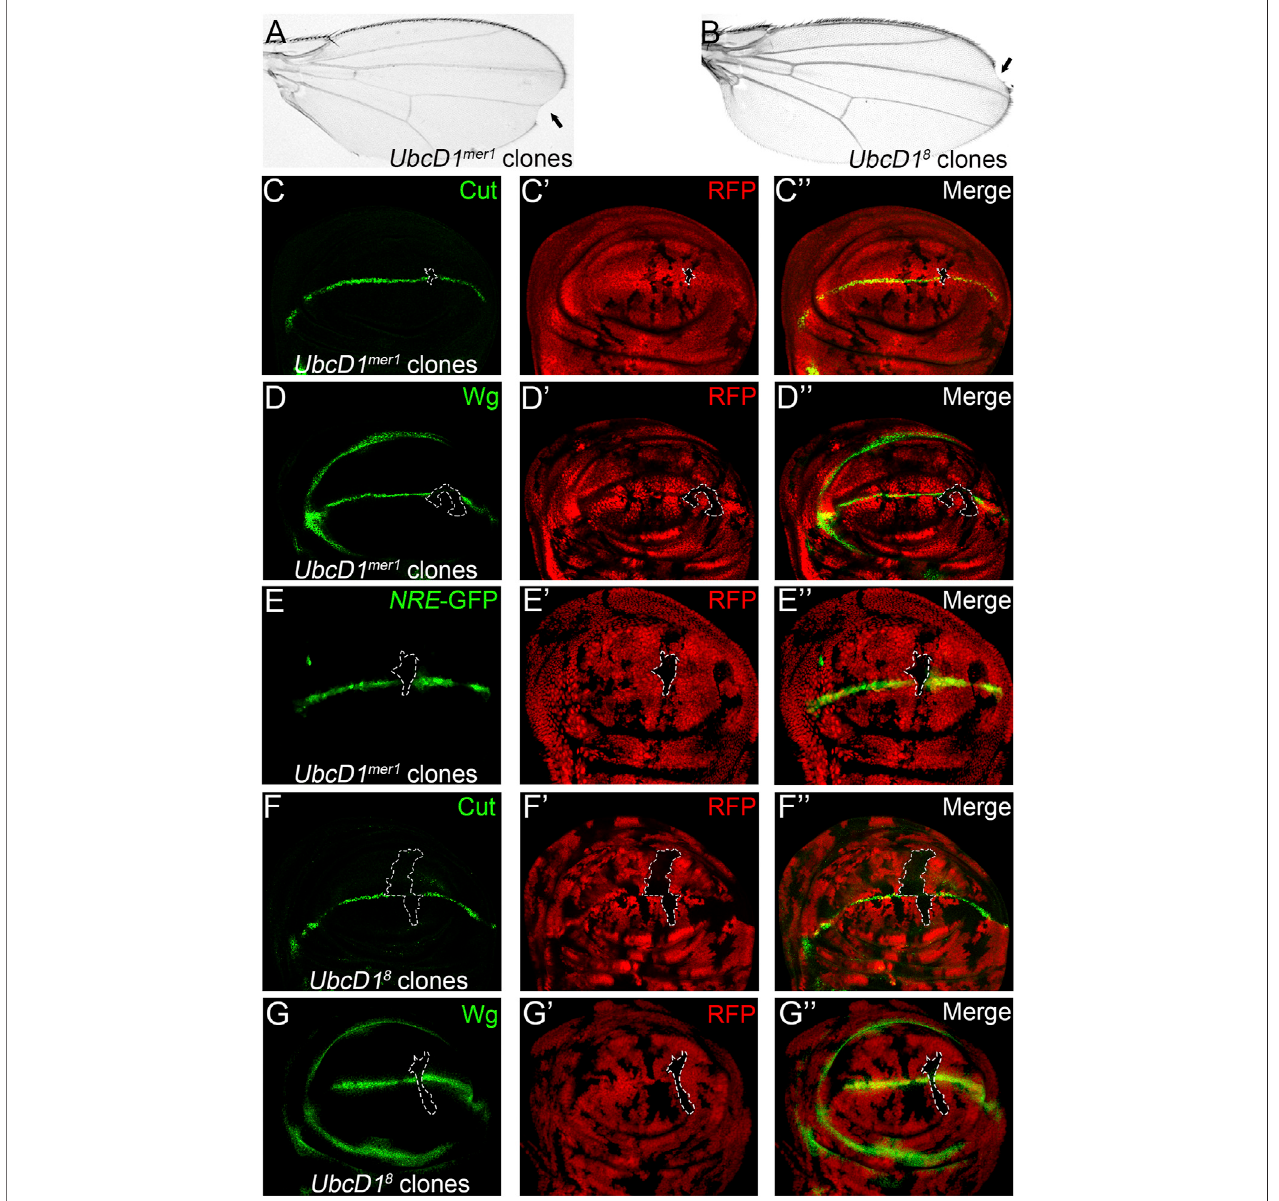
FIGURE 2 | UbcD1 mutants inhibit Notch signaling activity in Drosophila wing. (A – -B) Wing margin nicks (black arrow) are observed in fl y wings bearing UbcD1 mer1 (A) and UbcD1 8 (B) homozygous clones. (C – E) Expression of Notch signaling targets Cut (C) , Wg (D) and the reporter NRE -GFP (E) are abolished in UbcD1 mer1 homozygous mutant cells. (F – G) Expression of Cut (F) and Wg (G) are abolished in a subset of UbcD1 8 homozygous cells. Mutant clones are marked by absence of RFP. Representative mutant clones are circled by dashed lines. The expression pattern of Cut, Wg and NRE -GFP in wild type wing discs are shown in Supplementary Figure S1